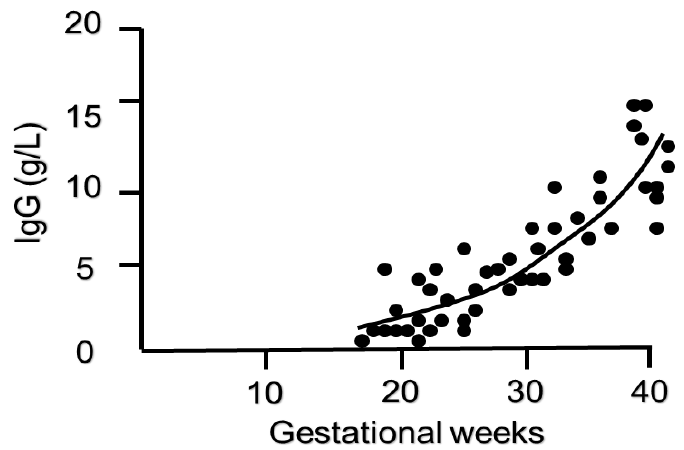
Figure 2. Timing of IgG transfer across the placenta in pregnancy (adapted from Malek A et al., Evolution of maternofetal transport of immunoglobulins during human pregnancy, Am J Reprod Immunol, 1996) [24].